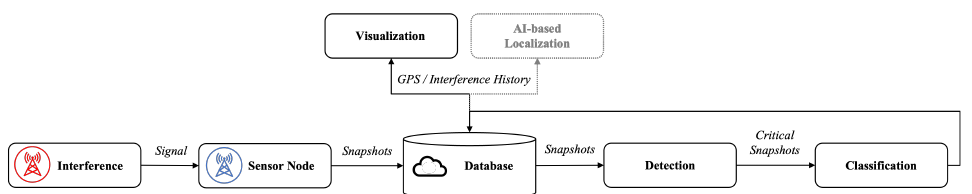
Figure 10. The ML-based pipeline detects, classifies, and visualizes potentially interfered GNSS signals. The boxes (outlined in black) represent all relevant pipeline components, and the iterative text on the edges represents the output/input of each component. Information flows from left to right. A database in the cloud synchronizes all information and thus provides the history of all events for downstream visualization and